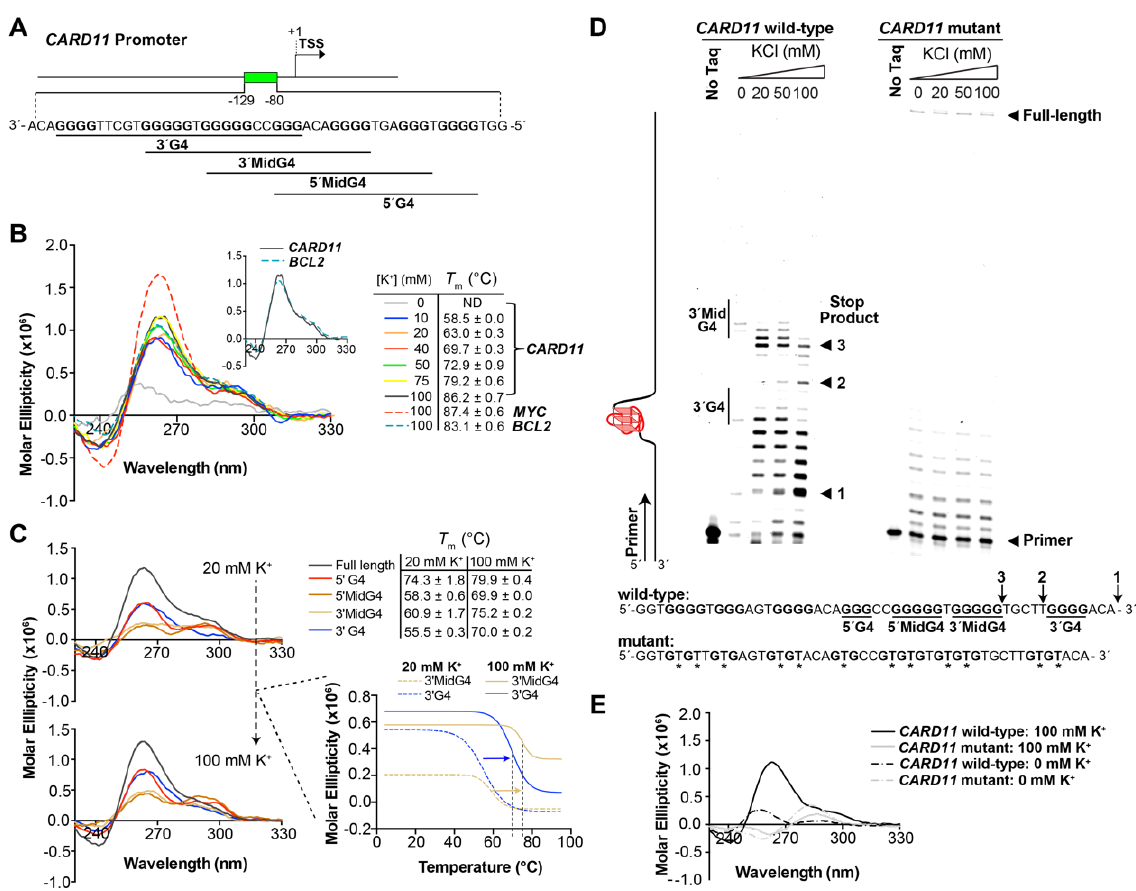
Figure 1. G-rich sequence in the CARD11 promoter regions forms G-quadruplex (G4) structures. ( A ) Schematic of the CARD11 promoter region with the potential G4 forming elements (green box) iden- tified in close proximity to the transcription start site (TSS). ( B ) Circular dichroism (CD) spectra of the CARD11 G4 sequence in the absence and presence of increasing concentrations of KCl. Corre- sponding melting temperatures (T m ) are provided. CD spectra of the established MYC (dashed red line) and BCL2 (dashed blue line) G4 forming sequences in 100 mM KCl served as controls. Inset, direct comparison of the CARD11 and BCL2 G4 sequence spectra at 100 mM KCl. Data represent three independent experiments. ( C ) CD spectra of the CARD11 G4 full-length, 5 ′ end, 5 ′ mid, 3 ′